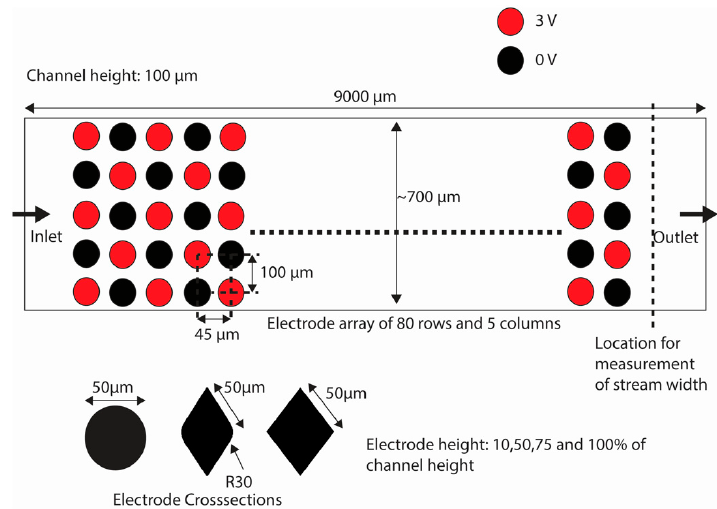
Figure 3. The top view of the model used for numerical analysis with the dimensions and electrode polarity is shown in the figure. The electrodes are arranged in a manner that they lie in straight rows and symmetrical rows. However, the electrodes are polarized alternately using either 3 or 0 V. The three cross-sections studied in this work are shown: circles, lens and diamonds. The model shown is not true to the scale, but represents the actual shape of the electrodes and channel.